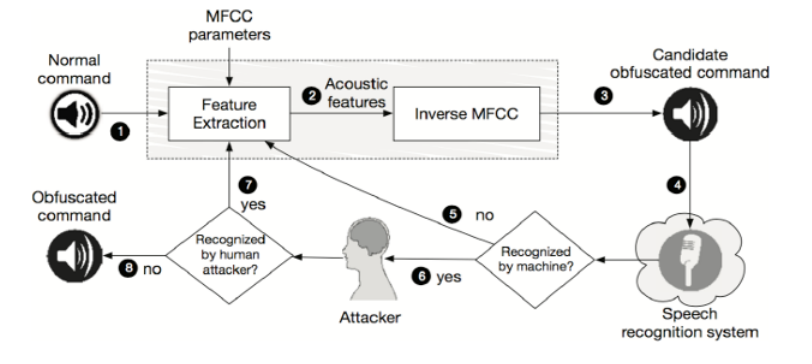
Fig. 1. Adversarial voice black box attack model.